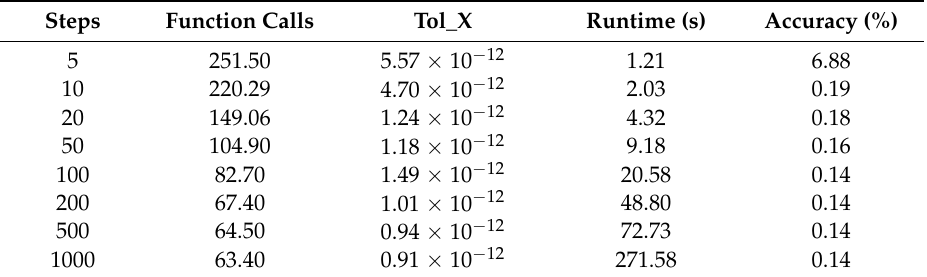
Table 4. Performance of the improved homotopy algorithm under different sampling steps.